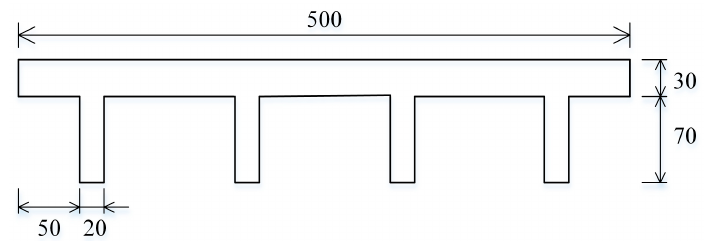
Figure 7. Configuration of the T-type girder (units: Figure 7. Con fi guration of the T-type girder (units: mm). Figure 7. Con fi guration of the T-type girder (units: mm). Figure 7. Con fi guration of the T-type girder (units: mm).